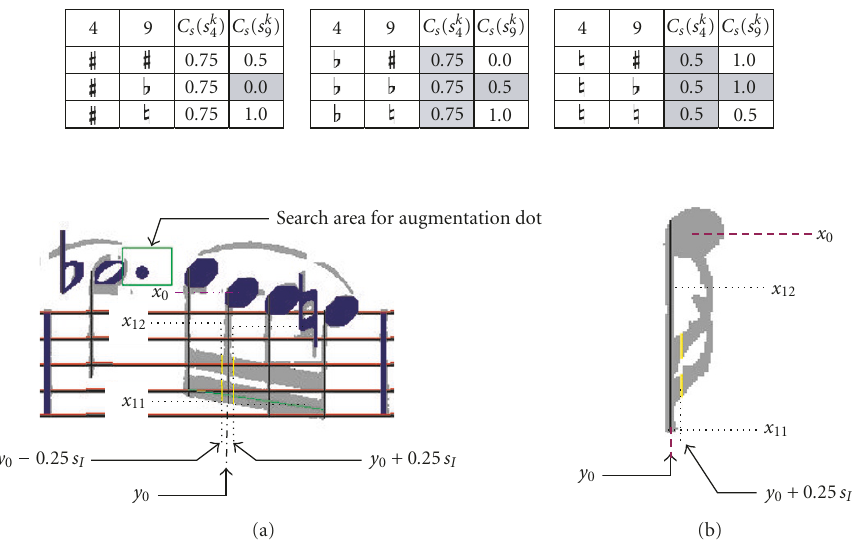
Table 4: Examples of compatibility coe ffi cients obtained for measure (b) and objects 4 and 9 . Shaded boxes correspond to accidental hypotheses with a graphical compatibility coe ffi cient with the next note head equal to 0 . 0.